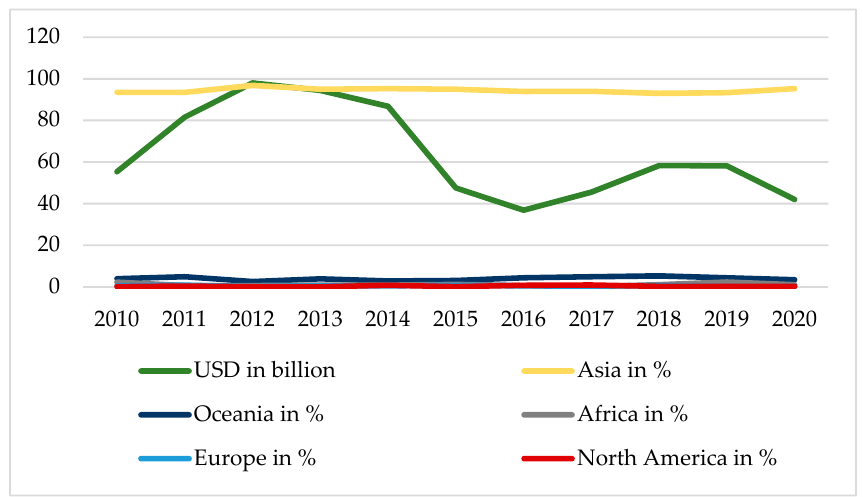
Figure 9. The UAE’s energy trade: crude oil export destination. Based on the OEC data [32]. The UAE is investing heavily in renewable energy, primarily solar energy. In 2013, the United Arab Emirates ranked third in the world in concentrated solar power (CSP) production. At that time, Shams 1 launch was one of the most global broad CSP facilities and the first commercial solar project in the Middle East. By the end of 2022, the biggest solar power plant in the world, called Al Dhafra Solar PV, should be completed in Abu Dhabi by the Emirates Water and Electricity Company. It will be able to reduce CO 2 emis- sions by 2.4 million metric tons per year. For comparison, it is around half a million car emissions. The research carried out supports the opinion of Tehreem, Mentel, Do ğ an, Hashim, and Shahzad—that these factors require reforms that promote economic and ex- port diversification to increase the share of non-oil production. However, critically judg- ing, energy consumption and trade are steadily increasing [33] (p. 8400). Another